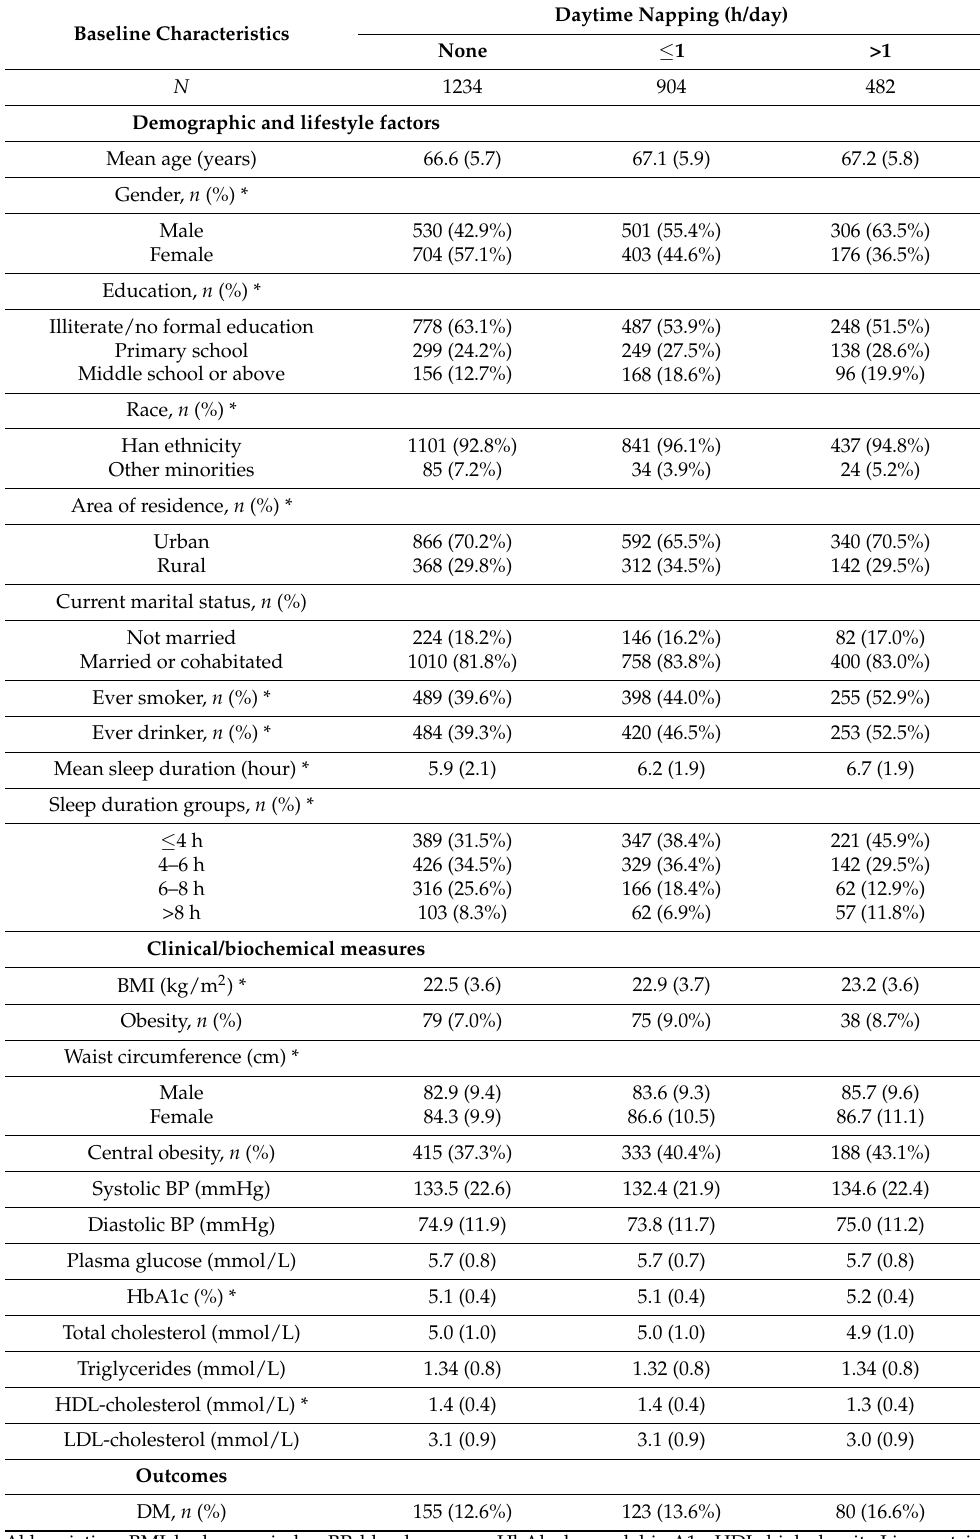
Table 1. Comparison of baseline characteristics according to different daytime napping